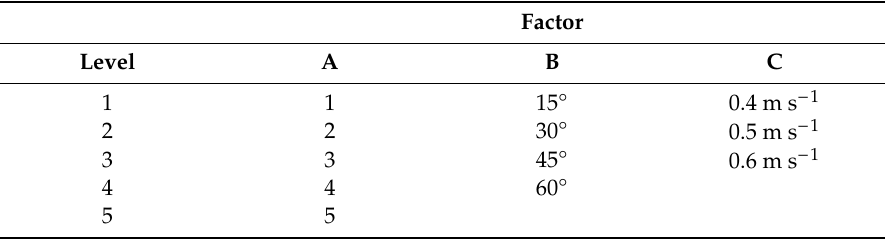
Table 1. Factor-level table for the orthogonal optimization of the tubular PBR.